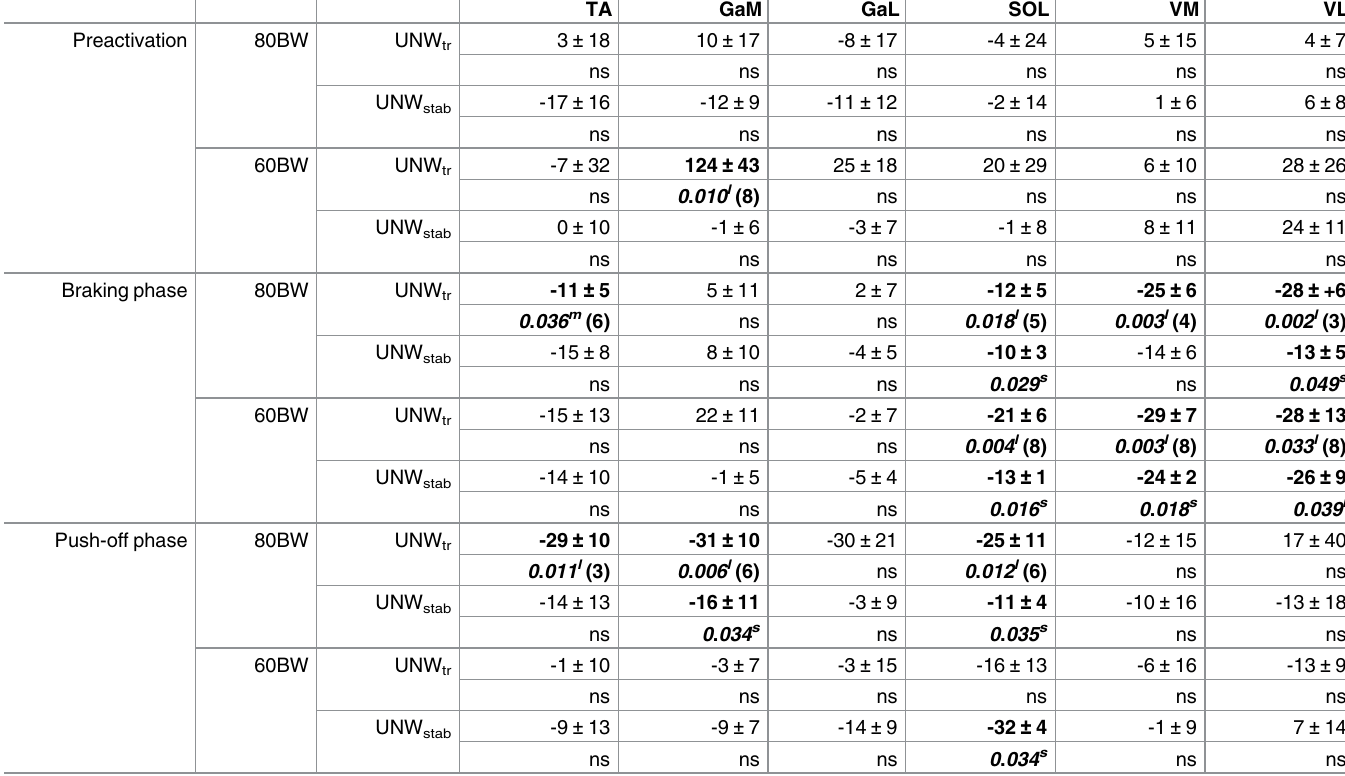
Table 2. Unweighting-induced changes (% INIT stab ) in mean EMG activity of the recorded left limb muscles during the transition (UNW tr ) and once stabilized (UNW stab ) in the 80BW and 60BW